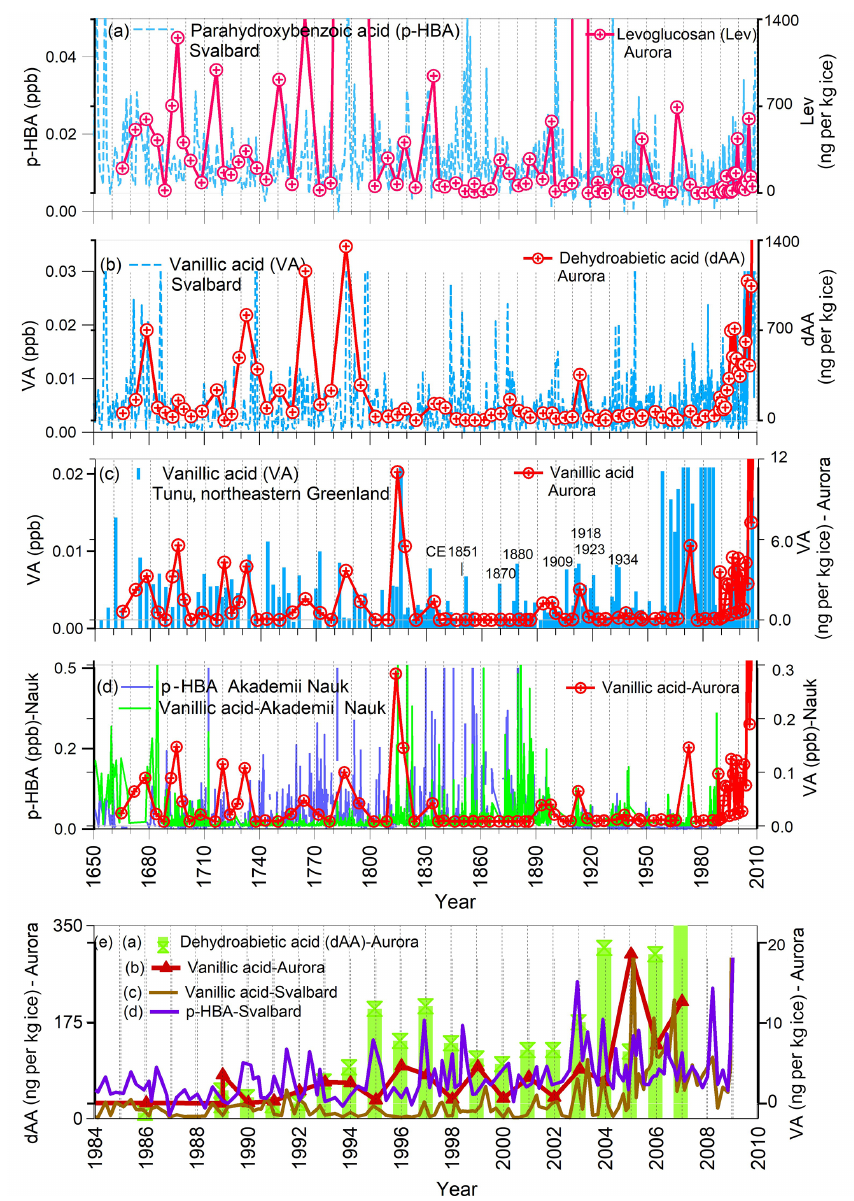
Figure 4. Historical trends of (a) p -hydrobenzoic acid ( p -HBA) of Svalbard; (b) vanillic acid (VA) of Svalbard; (c) VA of Tunu, Greenland; (d) p -HBA and VA of Akademii Nauk, with levoglucosan (Lev), dehydroabietic acid (dAA) and VA of Aurora Peak; and (e) historical trends of dAA and VA of Aurora and VA and p -HBA of Svalbard after the Great Pacific Climate Shift (1977–2007CE). p -HBA and VA of Svalbard are adopted from Grieman et al. (2018a), VA of Tunu, northeastern Greenland, is adopted from Grieman et al. (2018b), and p -HBA and VA of Akademii Nauk are adopted from Grieman et al.